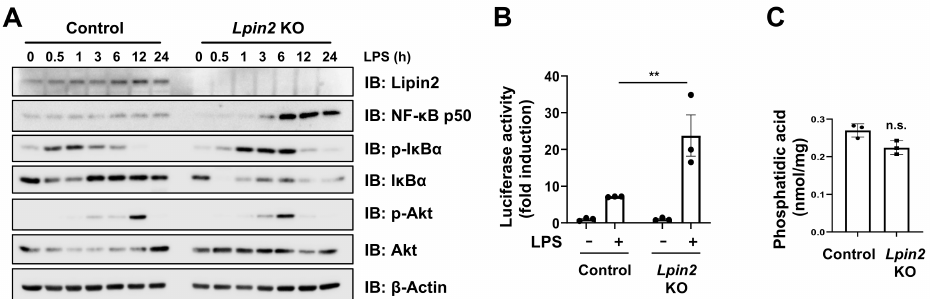
Figure 2. Lpin2 knockout induces NF- κ B signaling in RAW-D macrophages. ( A ) IB analysis of WCLs derived from control and Lpin2 KO RAW-D cells treated with 200 ng/mL LPS. The cells were harvested for IB analysis at the indicated time points. ( B ) A luciferase reporter assay showing relative NF- κ B activity in control and Lpin2 KO RAW-D cells with or without 200 ng/mL LPS treatment for 4 h. Data are means ± SD ( n = 3). ** P < 0.01; not significant, One-way ANOVA followed by multiple comparisons test. ( C ) Quantification of intracellular phosphatidic acid (PA) in control (WT) and Lpin2 KO RAW-D cells. Data are means ± SD ( n = 3), n.s., not significant, Student’s t -test.